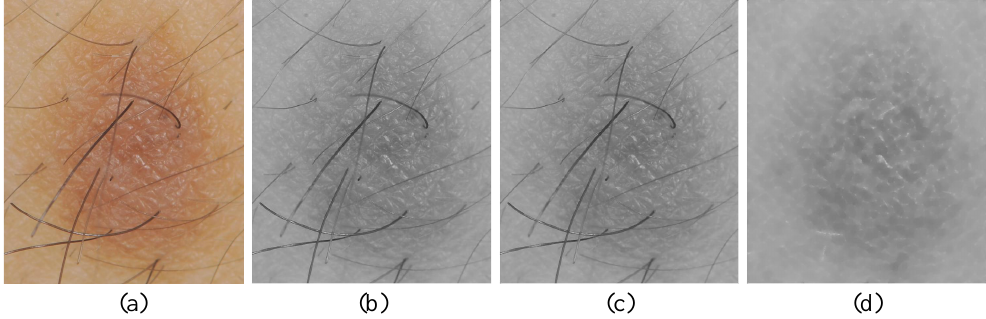
Figure 2. Main steps of preprocessing: ( a ) original image, ( b ) grayscale image, ( c ) noise removal with a median filter, and ( d ) hair artifacts removal with bottom-hat filtering. Lesion